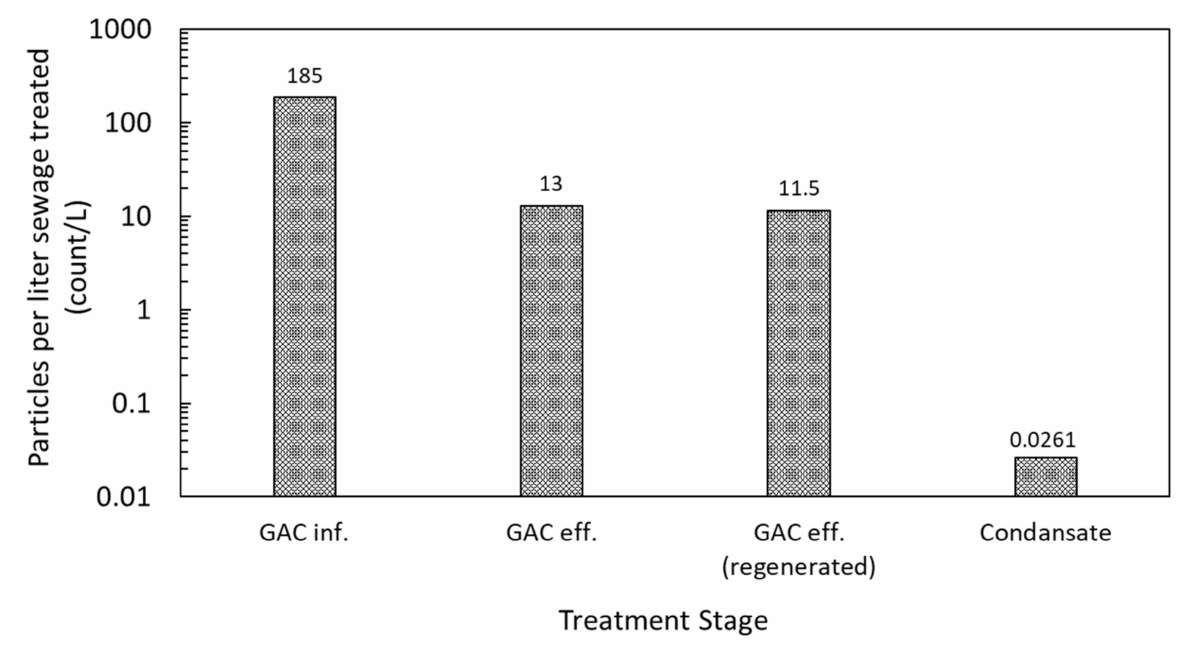
Figure 6. Number of MP particles in the wastewater with different stages of GAC treatment. Values are averages of two independent